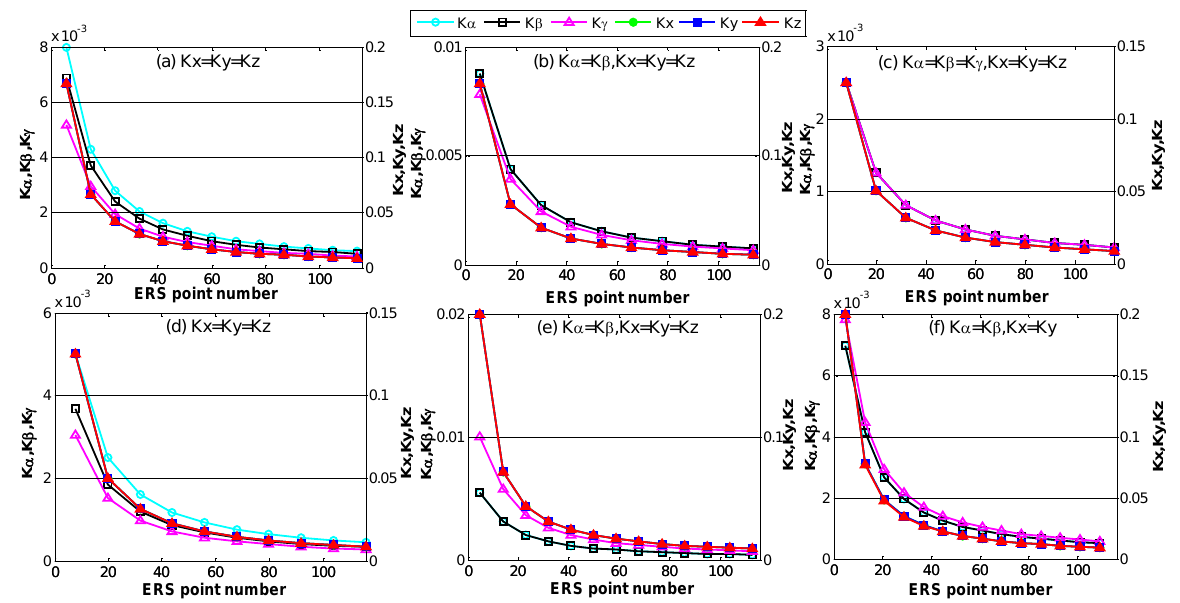
Figure 6. The sensitivity coefficients of transformation parameter errors versus ERS point number. ( a ) Sensitivity coefficients of layout a; ( b ) Sensitivity coefficients of layout b; ( c ) Sensitivity coefficients of layout c; ( d ) Sensitivity coefficients of layout d; ( e ) Sensitivity coefficients of layout e; ( f ) Sensitivity coefficients of layout